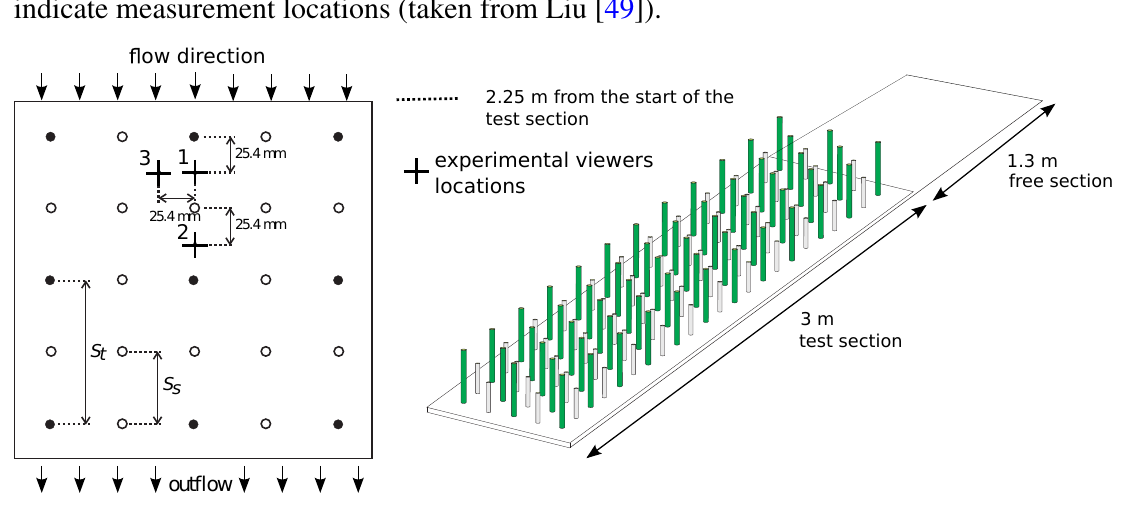
Figure 11. Dowel arrangement with measurement locations and 3D representation. The dowels are illustrated as circles, where solid circles represent tall dowels. The crosses indicate measurement locations (taken from Liu